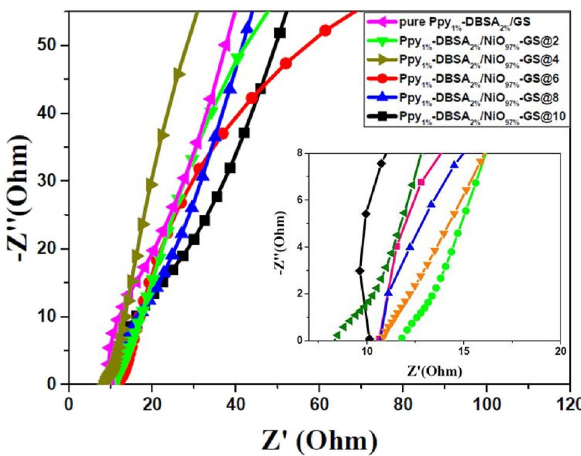
Figure 8. Nyquist plots (real impedance vs. imaginary impedance) of PPy/NiO electrodes with different currents in the frequency range of 0.01 Hz to100